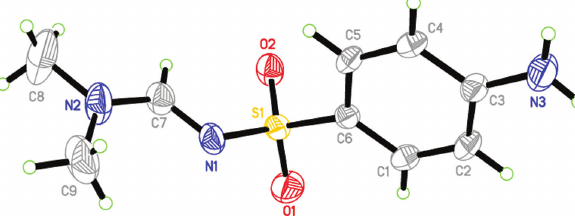
Table 1: Data collection and handling.